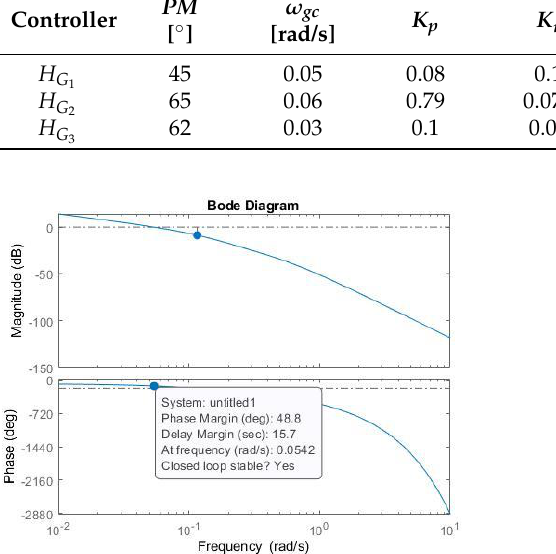
Figure 10. Bode diagram of the open-loop system for the first designed FO-PID controller.